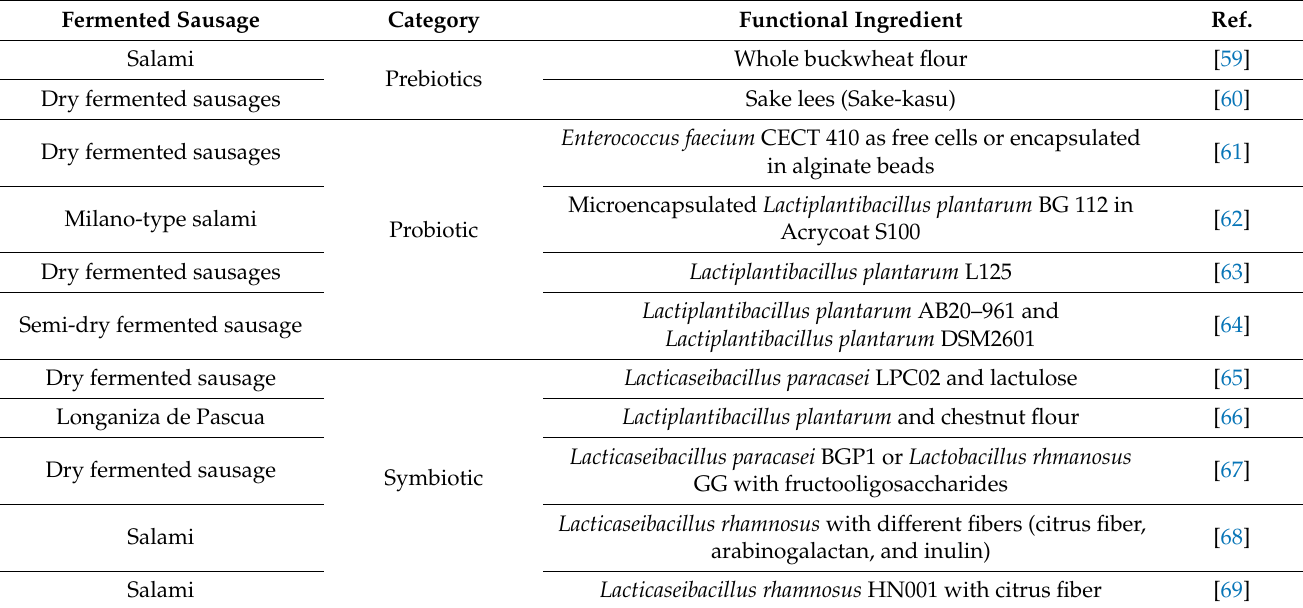
Table 2. Fermented sausages produced with prebiotics, probiotics, and